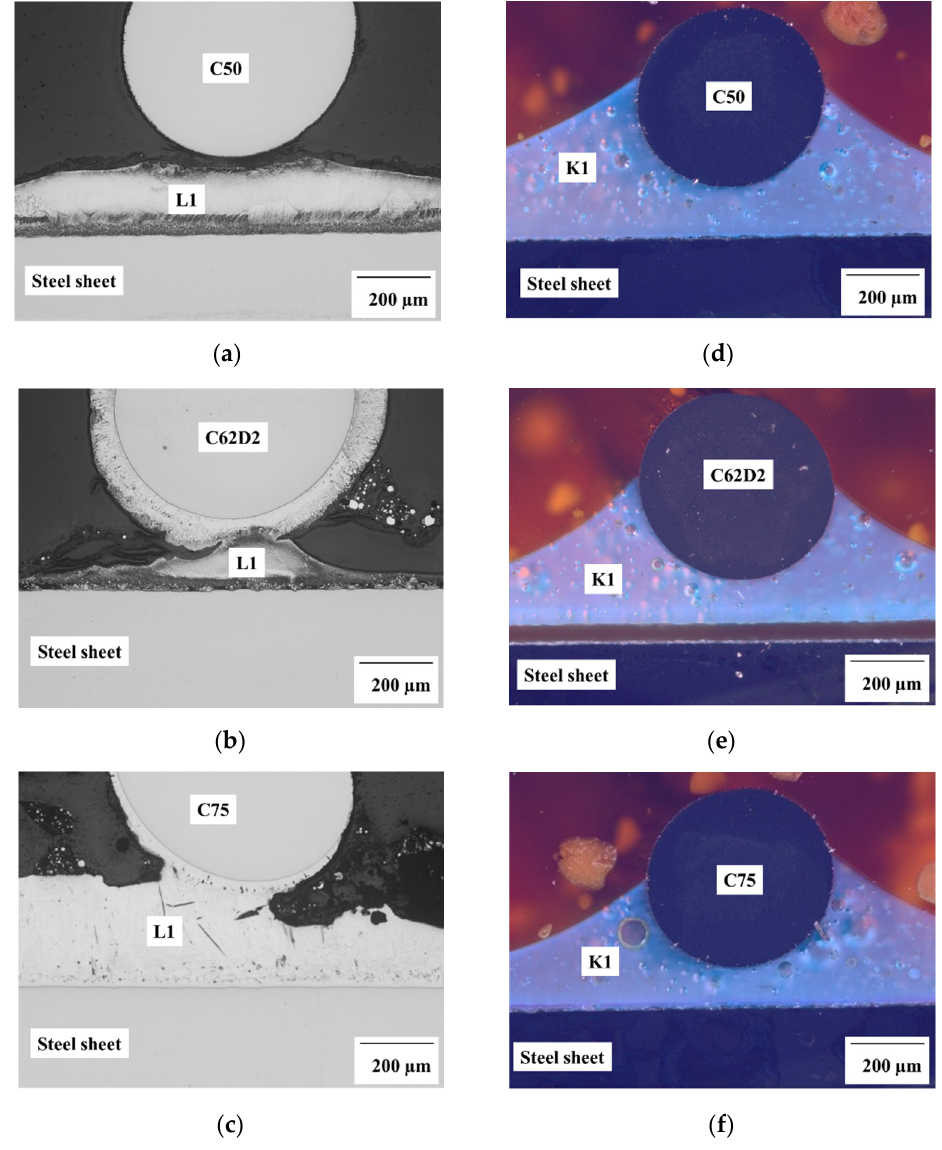
Figure 6. Light microscopy images of the L1 brazed ( a – c ) and the K1 adhesive glued ( d – f ) steel sheet–L1/K1–TWS joints using all the three different TWS. sheet–L1/K1–TWS joints using all the three different